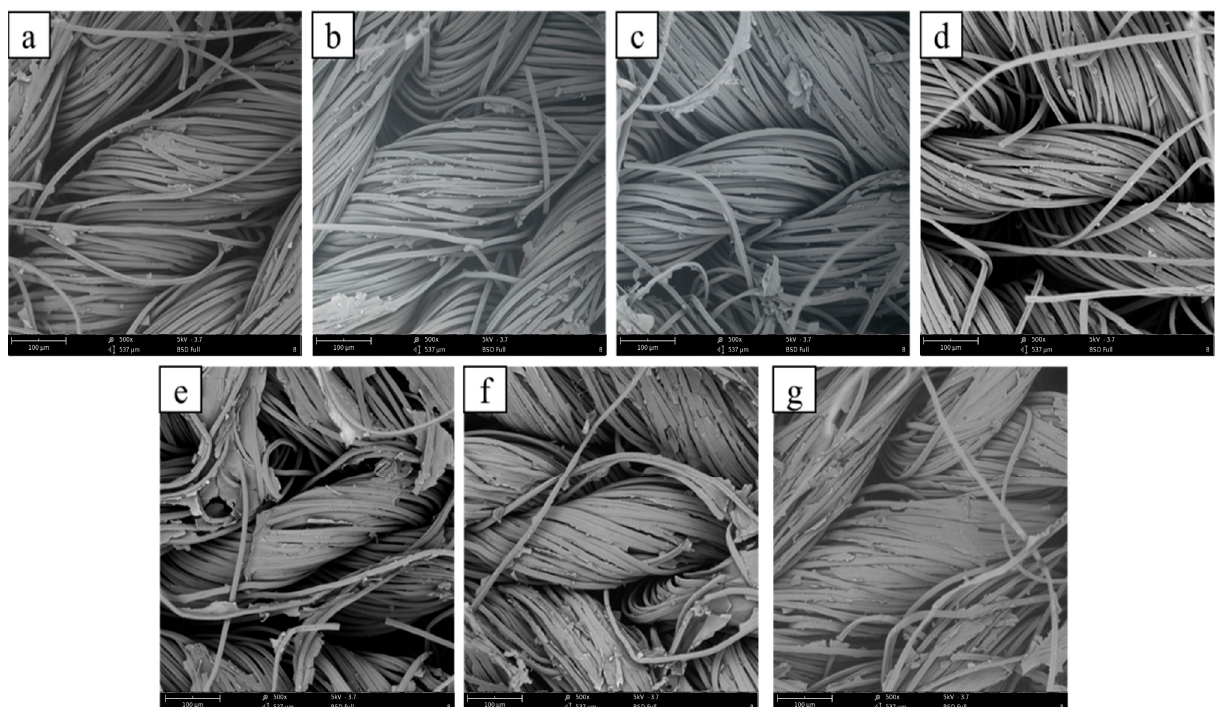
Figure 2. SEM images of conductive graphene fabric soaked 1-7 times (500×, ( a – g ) were soaked 1-7 times respectively).